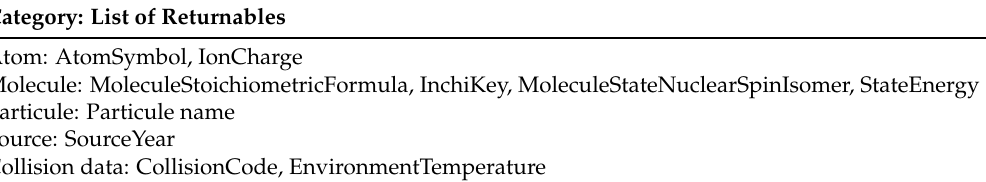
Table 7. List of BASECOL Restrictables metadata on the date of submission.